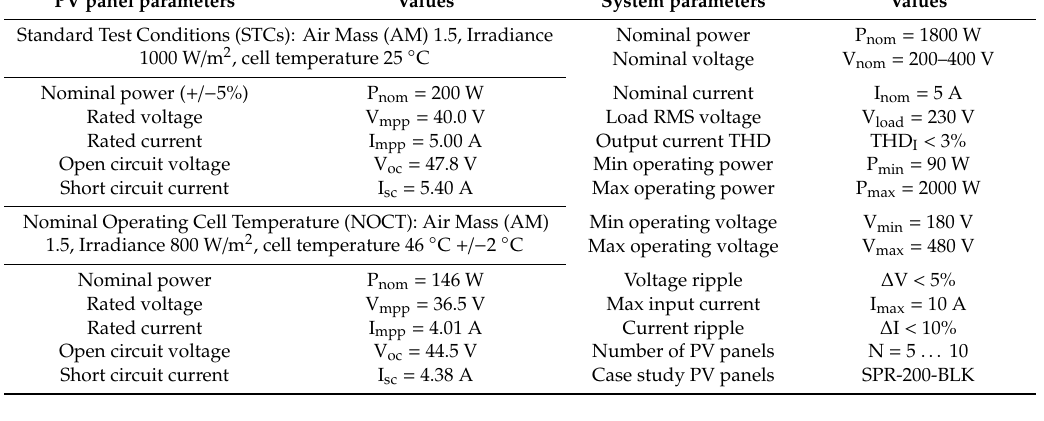
Table 2. Photovoltaic (PV) panel and system parameters.